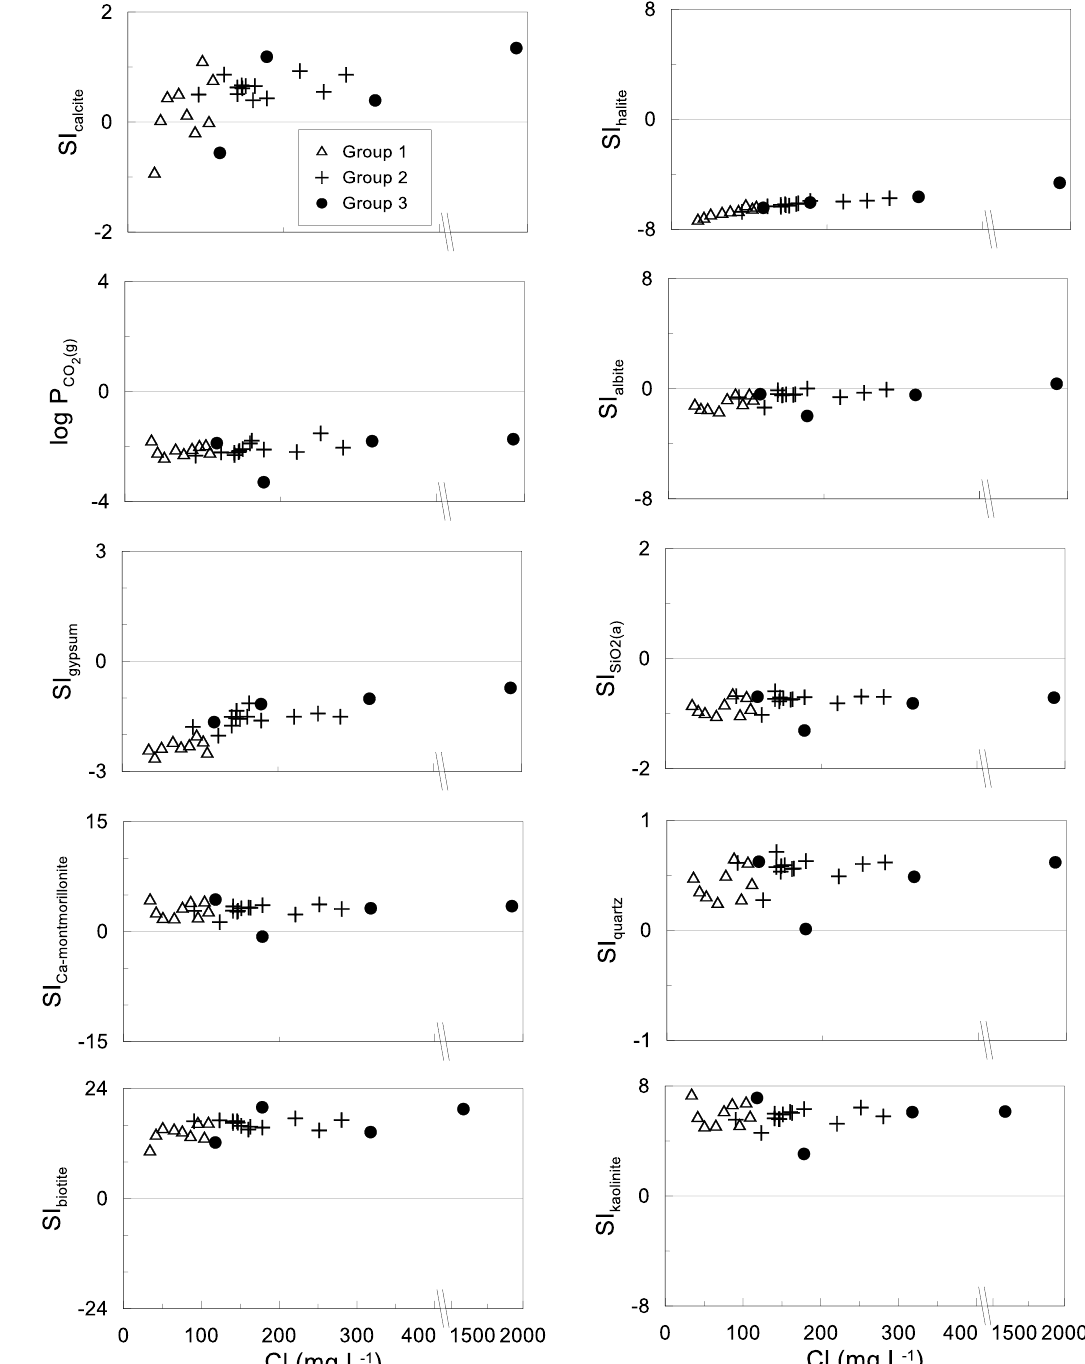
Figure 7. Saturation indexes versus chloride concentrations of relevant reacting mineral phases.